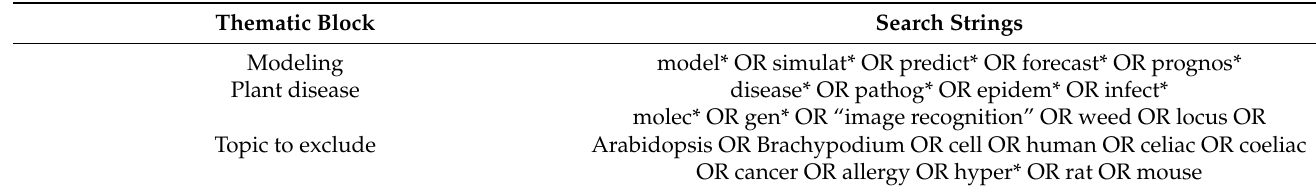
Table 1. Search strings for three thematic